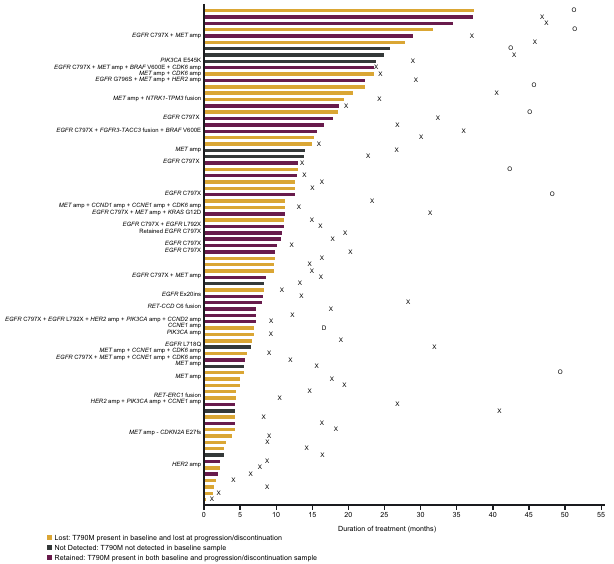
Lost: T790M present in baseline and lost at progression/discontinuation Not Detected: T790M not detected in baseline sample Retained: T790M present in both baseline and progression/discontinuation sample Fig.3|OsimertinibdurationoftreatmentbycandidatemechanismandT790M status. Swimmer plot indicating the duration of treatment with osimertinib (months) by candidate mechanism and T790M status ( n =78). Source data are provided in the Supplementary Data 1 fi le. X time of death for patients who have died, O date last known alive for patients who have not died, D time of study